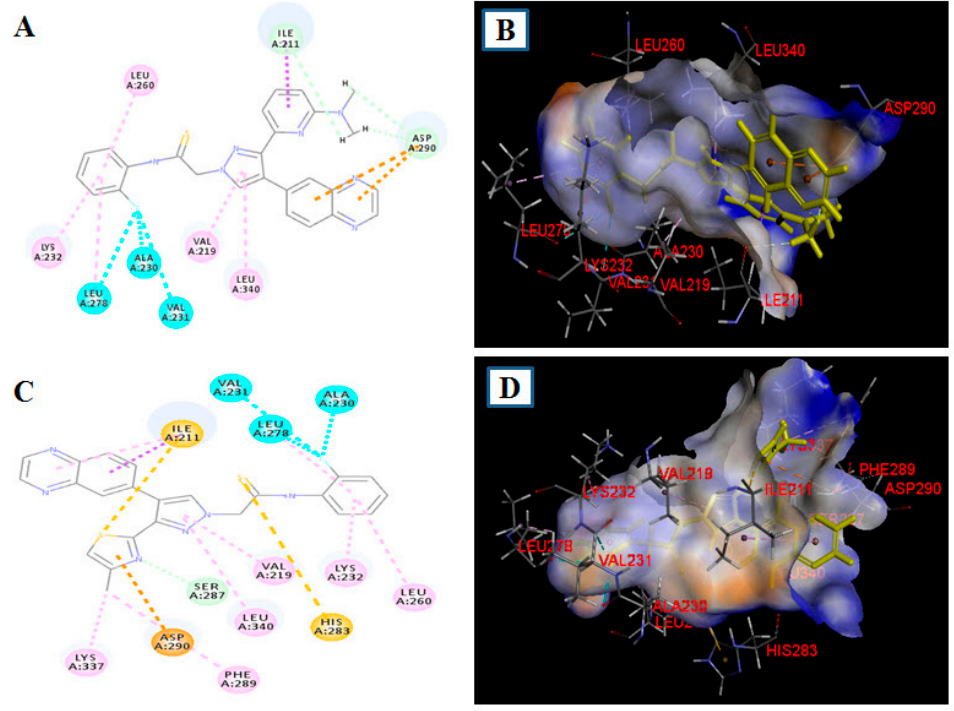
Figure 4. Docking pose of compounds 18b and 19b in the active site of ALK5 (PDB: 1RW8). ( A ) 2D binding model of 18b ; ( B ) Proposed pose of 18b in the binding pocket of ALK5; ( C ) 2D binding model of 19b ; ( D ) Proposed pose of 19b in the binding pocket of ALK5. The ligands are shown in yellow.